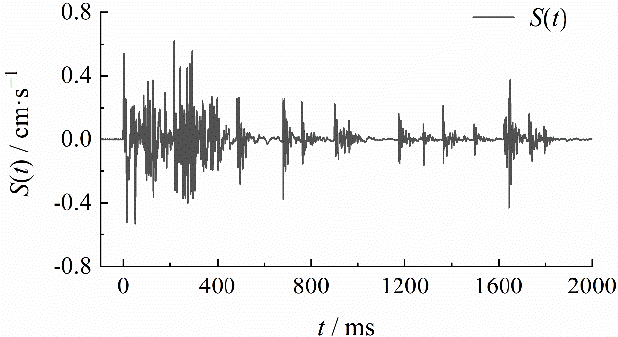
Figure 5. Observed wave.